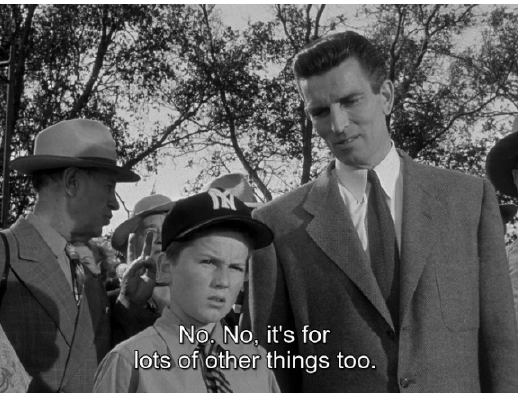
Figure 7. Klaatu’s disapproving face at Bobby’s ‘bombs’ comment. The Day the Earth Stood Still © 20th Century Fox. All Rights Reserved.